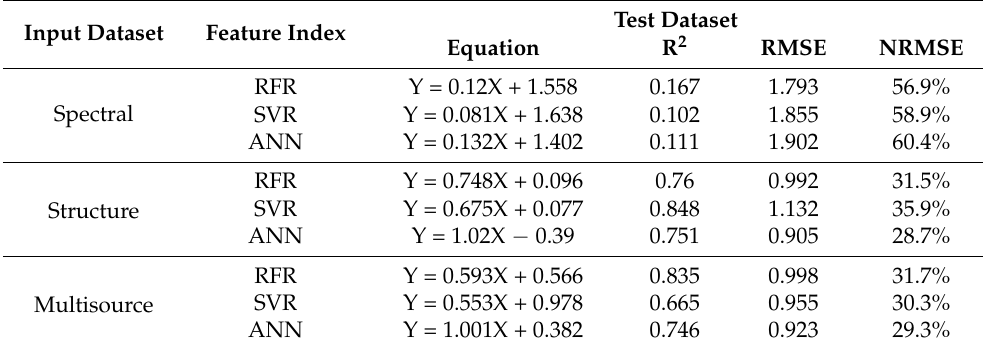
Table 6. Quantitative relationship between the LAI and measured values based on the machine learning models in test dataset (experiments B and C).